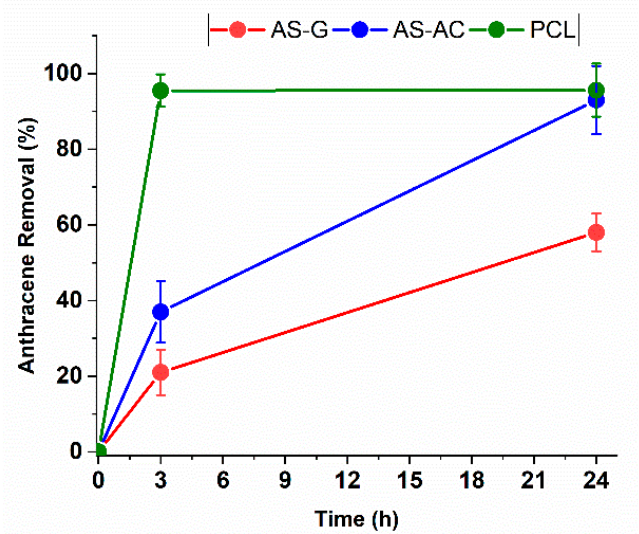
Figure 4. Kinetics of the removal of anthracene from aqueous solutions by the different materials: alginate spheres with encapsulated graphene (AS-G) or activated carbon (AS-AC) and polycaprolactone microparticles (PCL). The results shown are the mean ± SE from triplicate experiments. The removal efficiencies of the new-developed materials tested for the different OPs are resumed in Supplementary Table S1. AS-AC and PCL were the most efficient adsorbents of all OPs tested. AS-AC showed a removal efficiency for PAHs close to 90% or